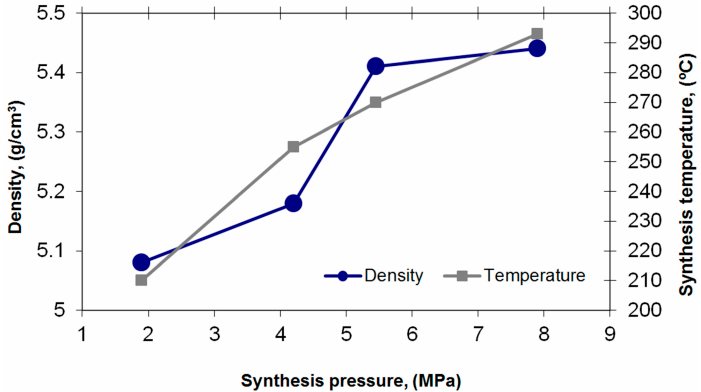
Figure 2. Effect of synthesis pressure on the density of zirconia nanoparticles produced in hydrothermal process [10]. At the pressure of 5.5 MPa, corresponding to 270 °C, the particles were transformed from non-fully reacted to fully